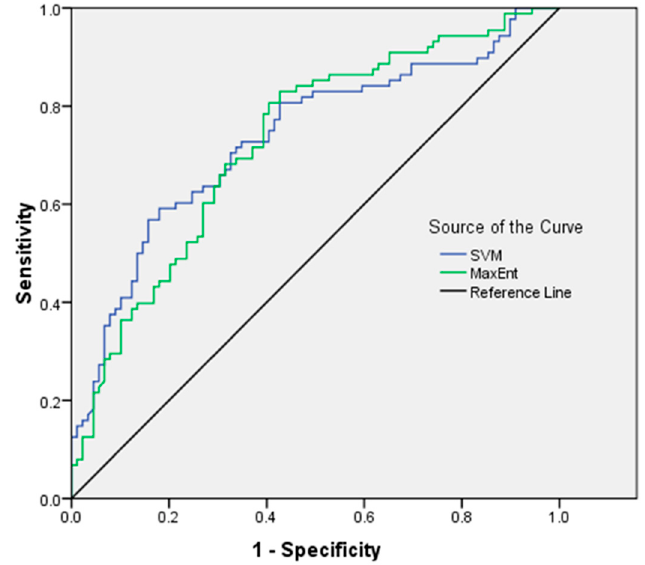
Figure 6. Receiver operator characteristic (ROC) curve of sensitivity vs specificity of Juniperus habitat for SVM and MaxEnt models.